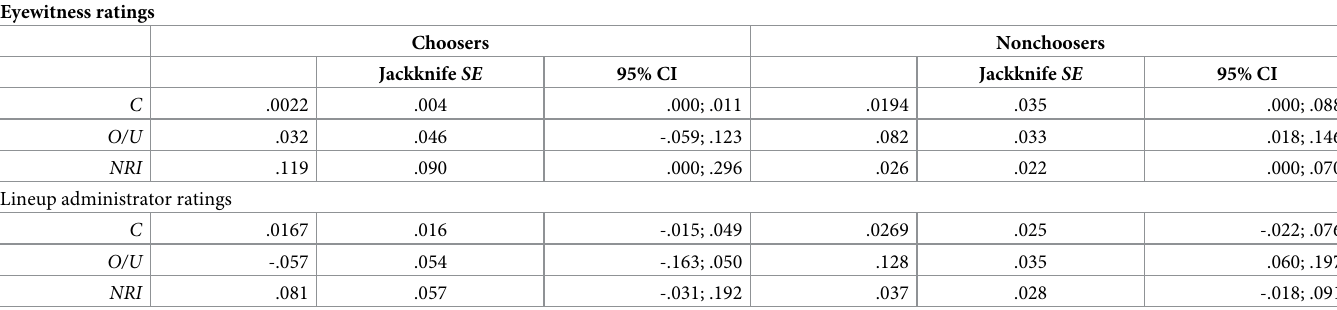
Table 2. Calibration statistics for choosers and nonchoosers for eyewitness and lineup administrator confidence ratings of eyewitness accuracy. Eyewitness